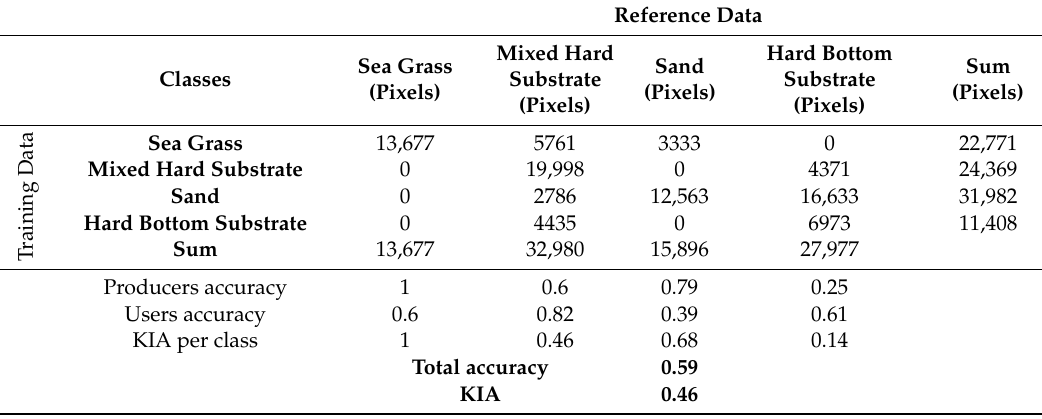
Table 7. Accuracy matrix for the multispectral orthomosaic applying the fuzzy